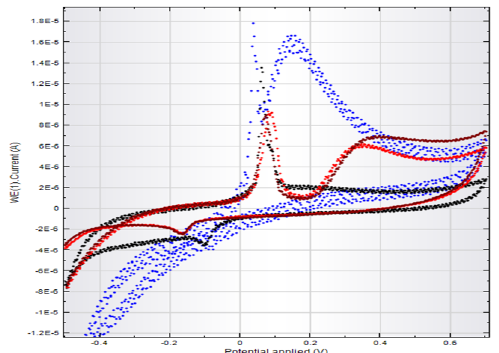
Figure A7. Overlapped CVs for the oxidation signal obtained for 0.5 mM H 2 O 2 in the absence (blue) and in the presence of 0.5 mM of the novel synthesized compounds: 5a (red) and 5b (brown) prepared in 0.1 M KCl on Au SPE. Black line: CV recorded in 0.1 M KCl.